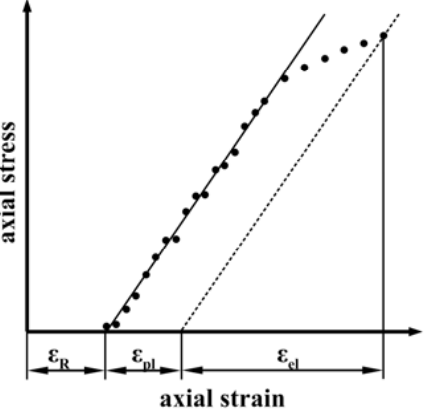
Figure 4. Schematic representation of the axial stress–strain curve within a probe. Decomposition of total axial strain into elastic, plastic, and residual components.